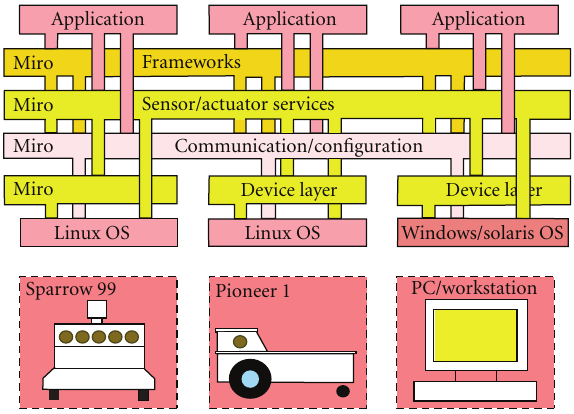
Figure 3: MIRO abstraction layers (© (2002) IEEE) (reproduced from [33]).